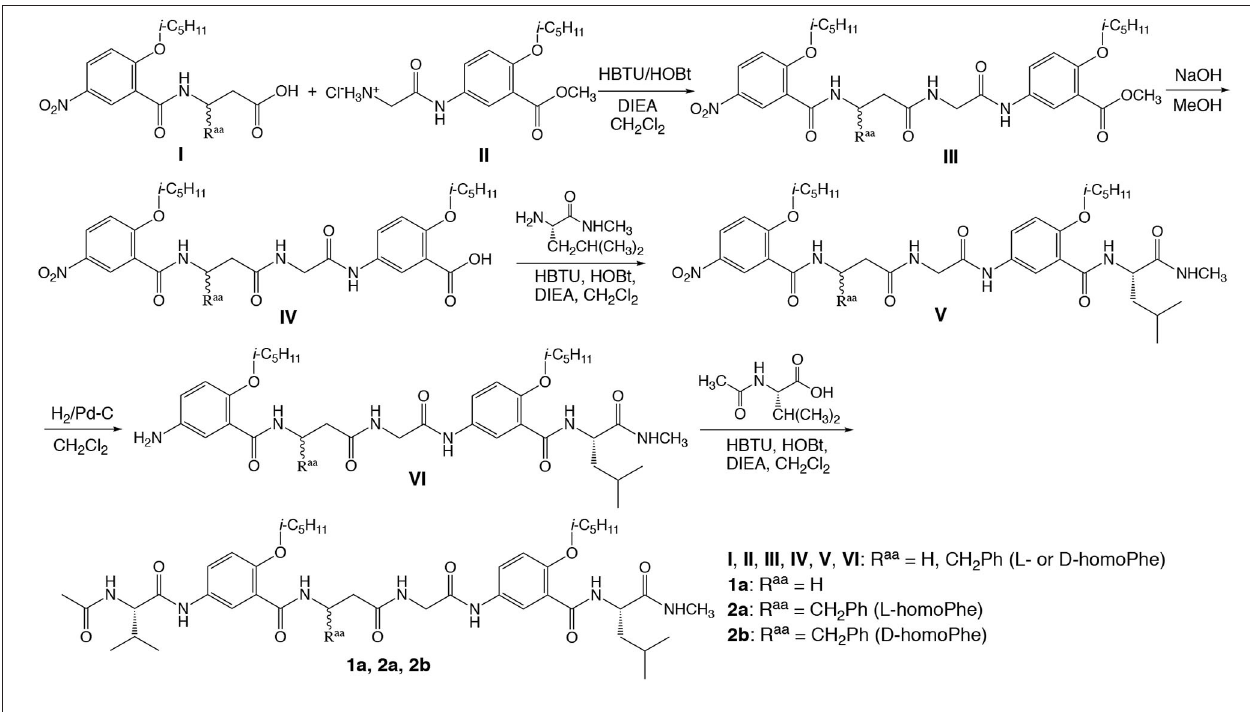
FIGURE 1 | Synthesis of hybrid hexapeptides 1a , 2a , and 2b .